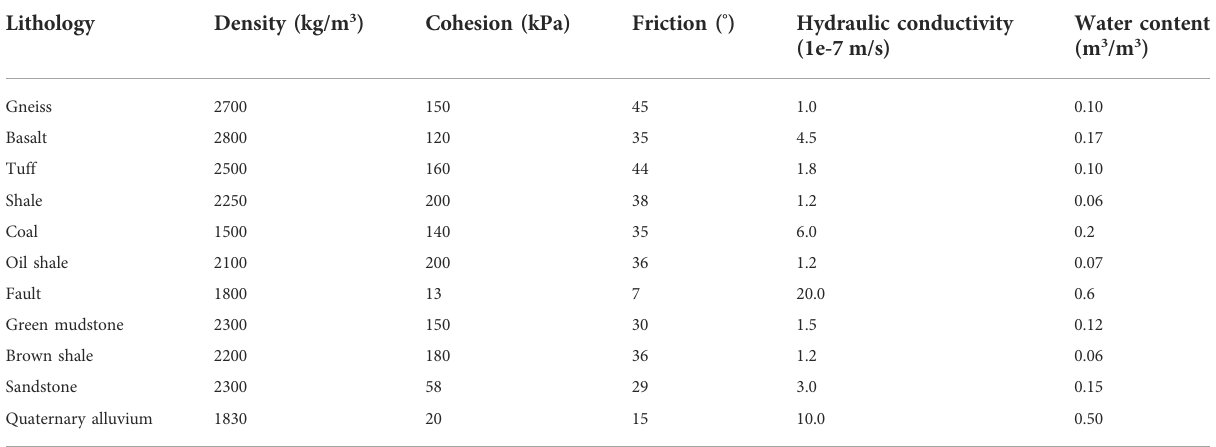
TABLE 1 Mechanical and hydraulic parameters of rock